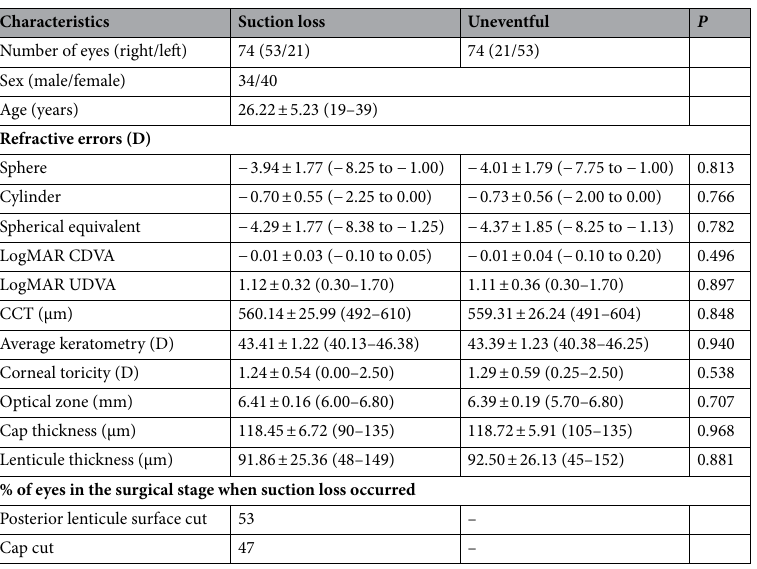
Table 1. Characteristics of eyes that underwent immediate SMILE reapplication after Suction loss and contralateral uneventful SMILE. Results are expressed as mean ± standard deviation (range). CDVA corrected distance visual acuity, D diopter, logMAR logarithm of the minimum angle of resolution, UDVA uncorrected distance visual acuity, CCT central corneal thickness.